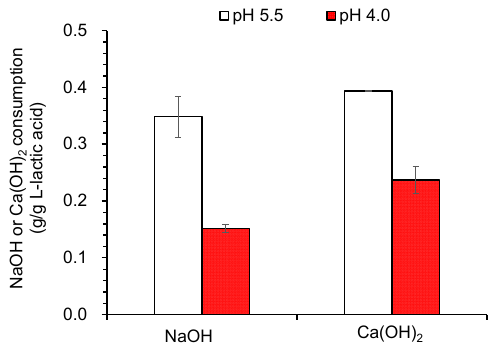
Figure 4. The dosage of NaOH or Ca(OH) 2 for cellulosic L-lactic acid fermentation in the evolved P. acidilactici strain at pH 4.0 and 5.5. The cellulosic L-lactic acid fermentation was performed by simultaneous saccharification and co-fermentation (SSCF) of 5% ( w / w ) solids loading wheat straw for 24 h, and the enzyme dosage was 10 mg protein/g cellulose. The condition was controlled at 42 °C and 400 rpm. The pH was controlled by automatically adding 4 M NaOH or 25% ( w / w ) Ca(OH) 2 slurry. According to Student’s t test, the reduction in NaOH or Ca(OH) 2 was significant, with p < 0.05.